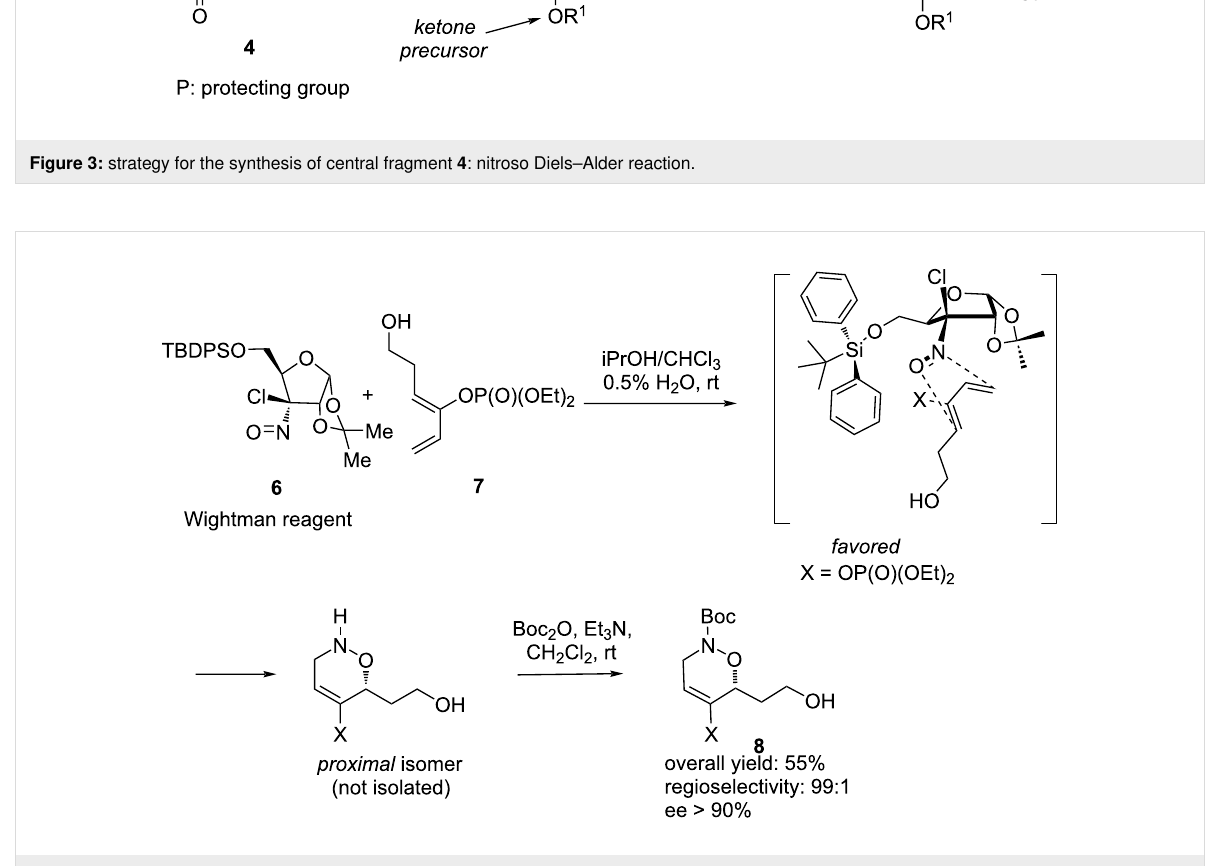
Scheme 1: A highly regio-and stereoselective nitroso Diels–Alder cycloaddition between Wightman’s reagent 6 and a dienic enol